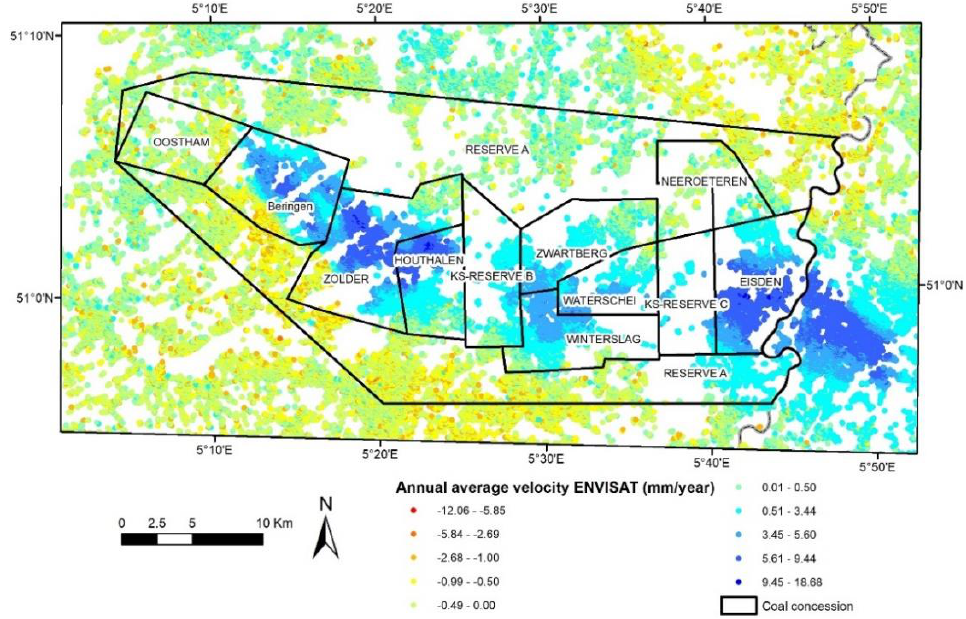
Figure 5. Color classification based on the average annual LOS velocities of PS points for ENVISAT (2003 – 2010) and extension of the coal concessions in Limburg.